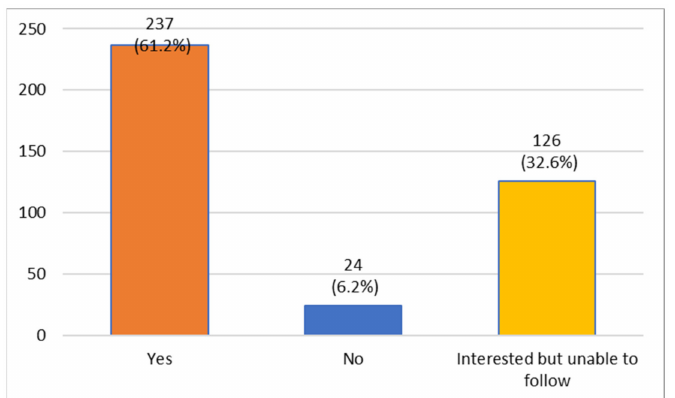
Figure 8. Distribution of the answers given by children regarding healthy nutrition.